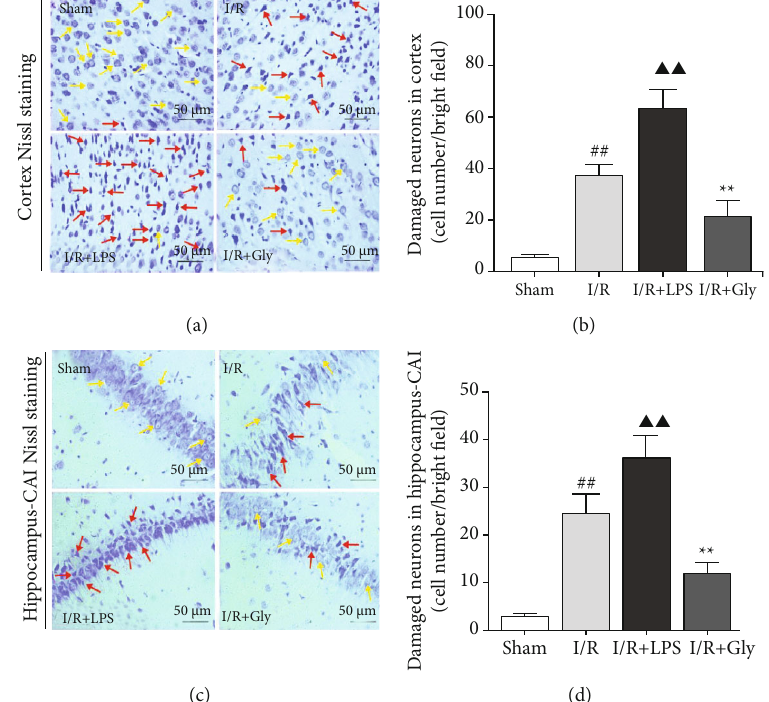
Figure 6: In fl uences of pyroptosis on neurons survival at 24h after reperfusion. (a, c) Representative pictures of ischemic cortex and hippocampus-CA1 Nissl staining. Yellow arrows represent normal morphology of neurons with clear nucleolus, abundant cytoplasm, and intact structure. Red arrows represent abnormal neurons appeared shrunken and deep stained, scale bars, 50 μ m. (b, d) Quantitative analysis of damaged neurons in the cortex and hippocampus-CA1 areas, n = 6 . Data are presented as mean ± SD . ## P < 0 : 01 , I/R group versus sham group; ▲▲ P < 0 : 01 , I/R + LPS group versus I/R group; ∗∗ P < 0 : 01 , I/R + Gly group versus I/R group.